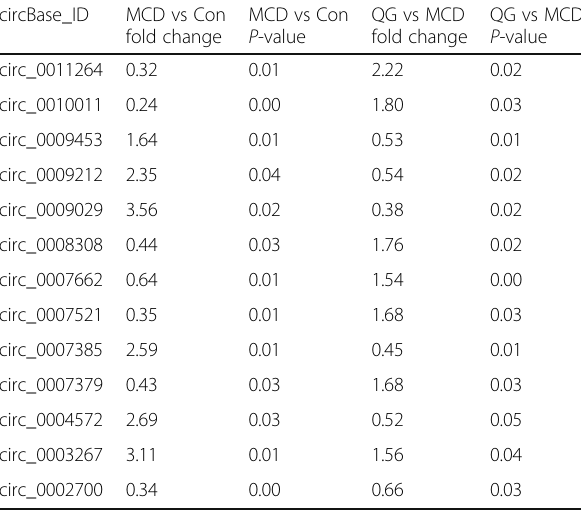
Table 5 Representative overlapped differentially